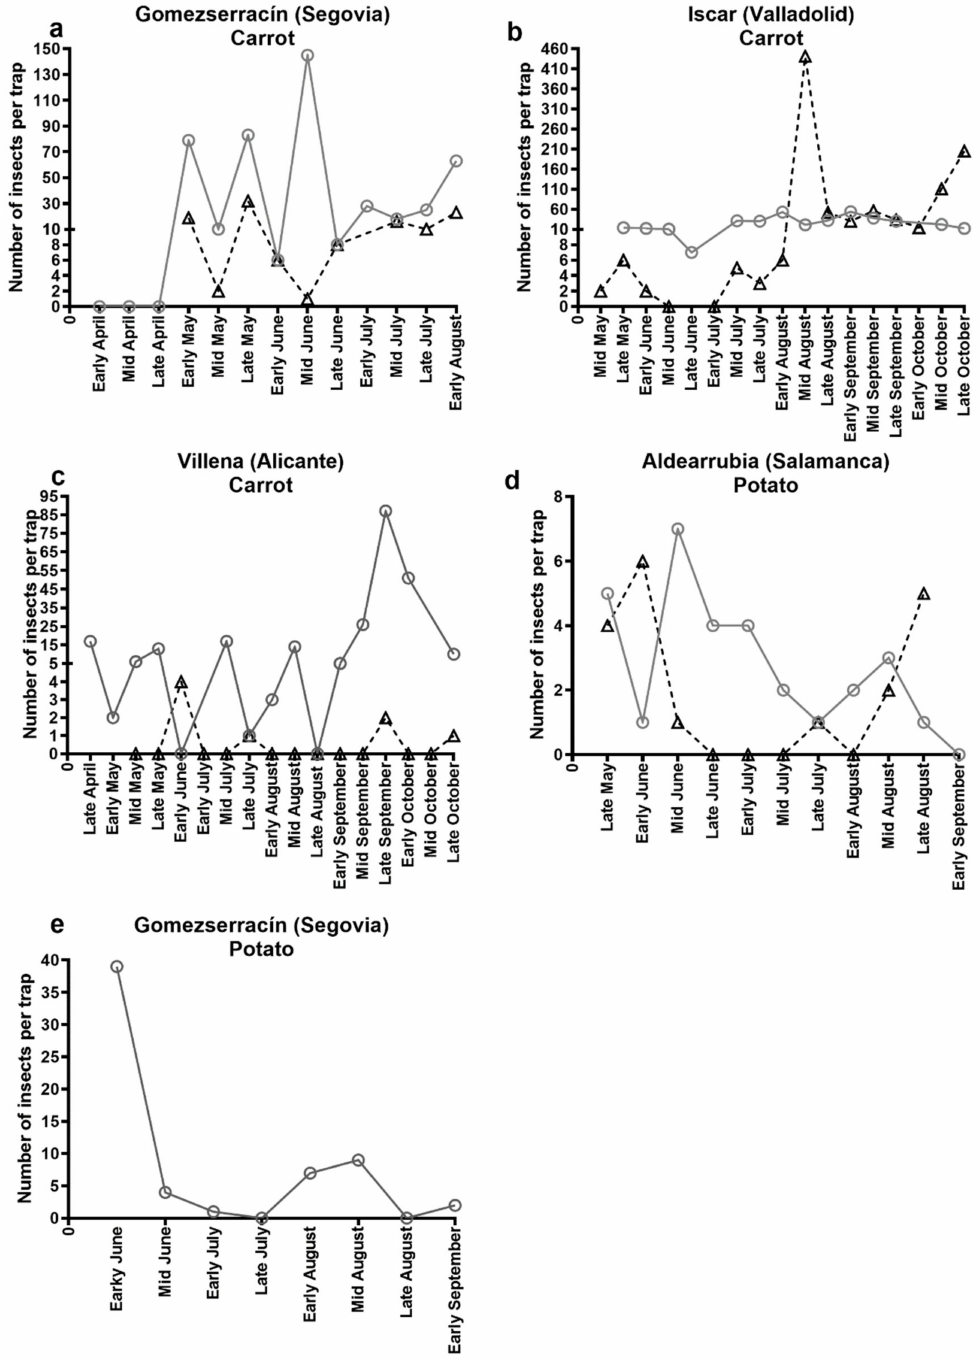
Figure 2. Total number of psyllids ( B. trigonica + B. nigricornis ) collected by horizontal green water tile traps in 2016 (grey circles and solid line) and 2017 (black, triangles and dashed line). Samples were collected in carrot fields, ( a ) Gomezserrac í n, ( b ) Í scar, ( c , d ) Villena or in potato fields, ( e ) Aldearrubia and ( f ) Gomezserrac í